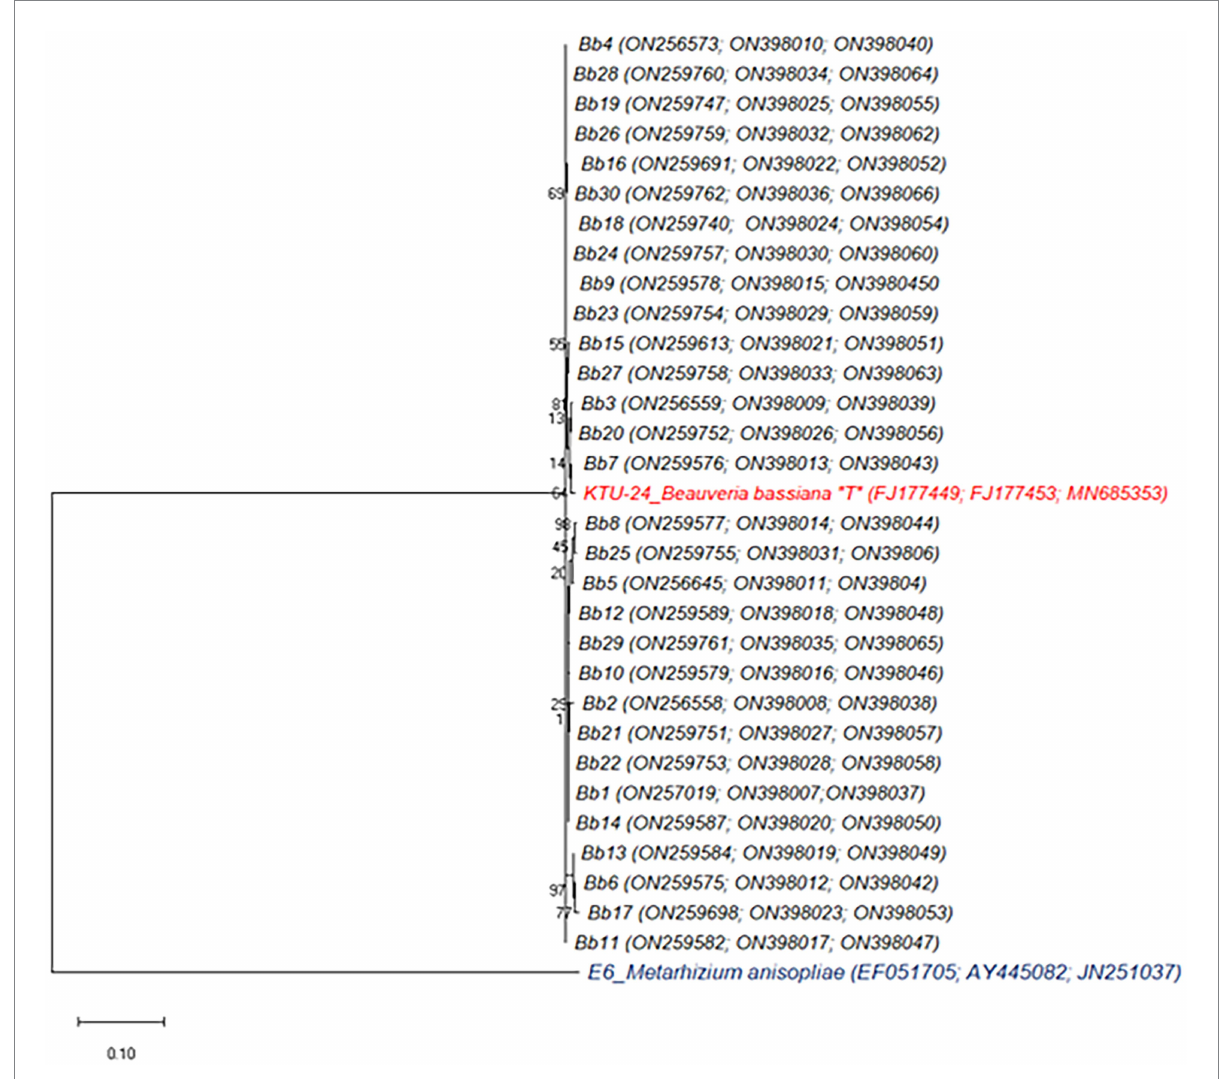
FIGURE 2 Phylogenetic analysis of B. bassiana isolates based on combined partial ITS+TEF + Bbchit1 sequences. The dendrogram was constructed by using Maximum Likelihood method with the kimura 2-parameter model with MEGA 10 version. Isolate representing ex-type material is marked with “T.” Bootstra p values shown next to nodes are based on 1,000 replicates. The tree was rooted using isolate Metarhizium anisopliae E6 as the